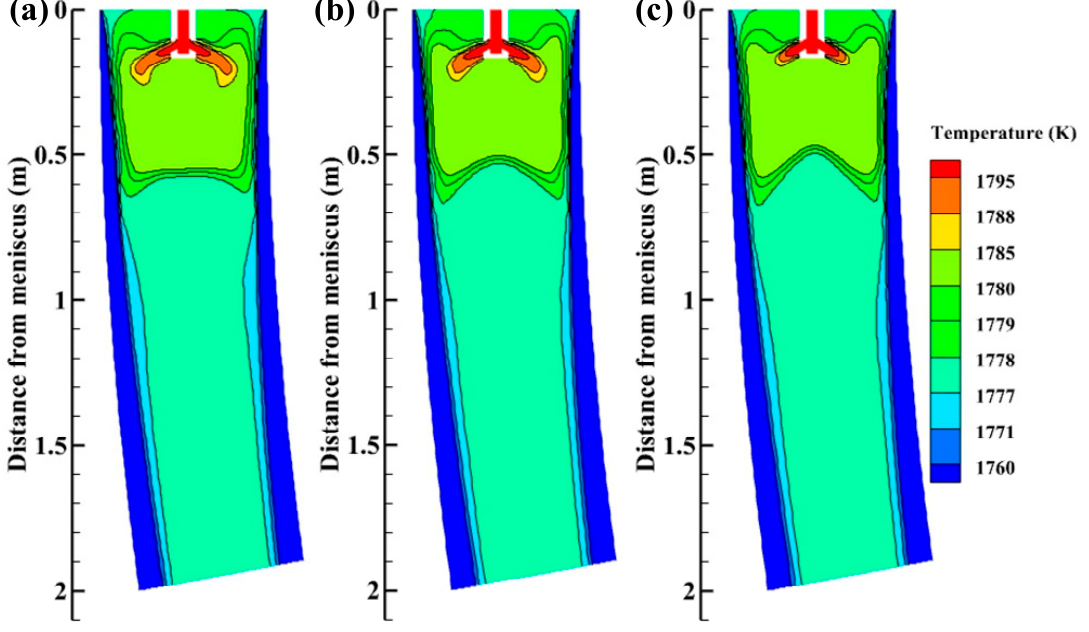
Figure 14. Temperature distributions on the plane Y = 0 m with M-EMS ( a ) − 15 ◦ SFN, ( b ) 0 ◦ SEN, and ( c ) +15 ◦ SFN.